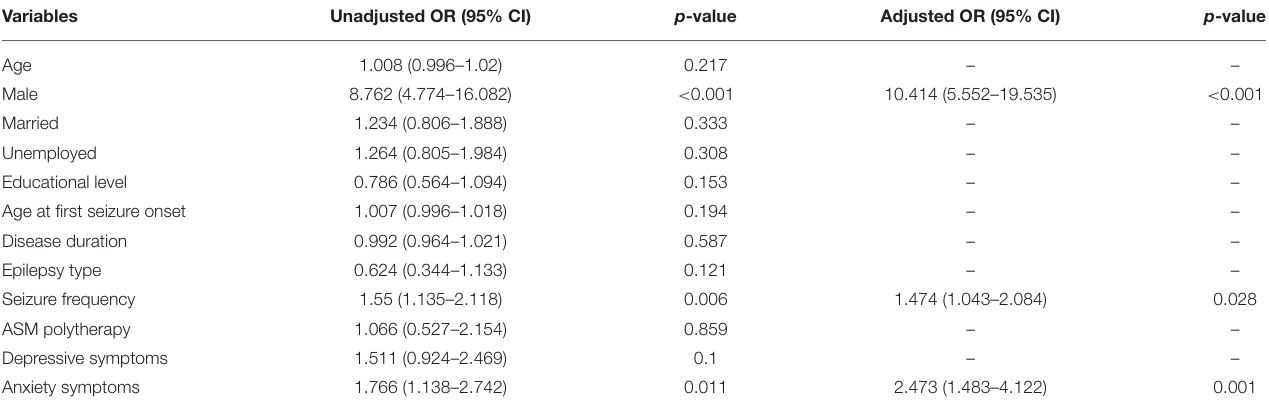
TABLE 4 | Univariate and multivariate logistic regression analyses for independent factors associated with cigarette smoking in